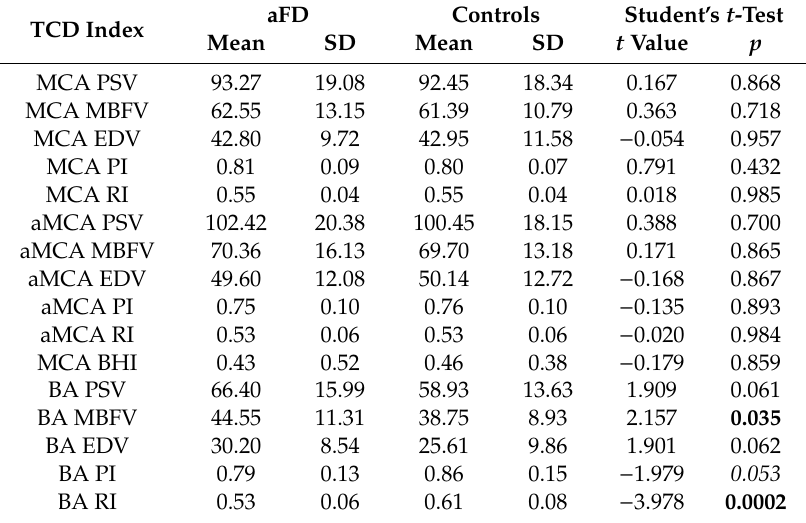
Table 2. TCD data of both